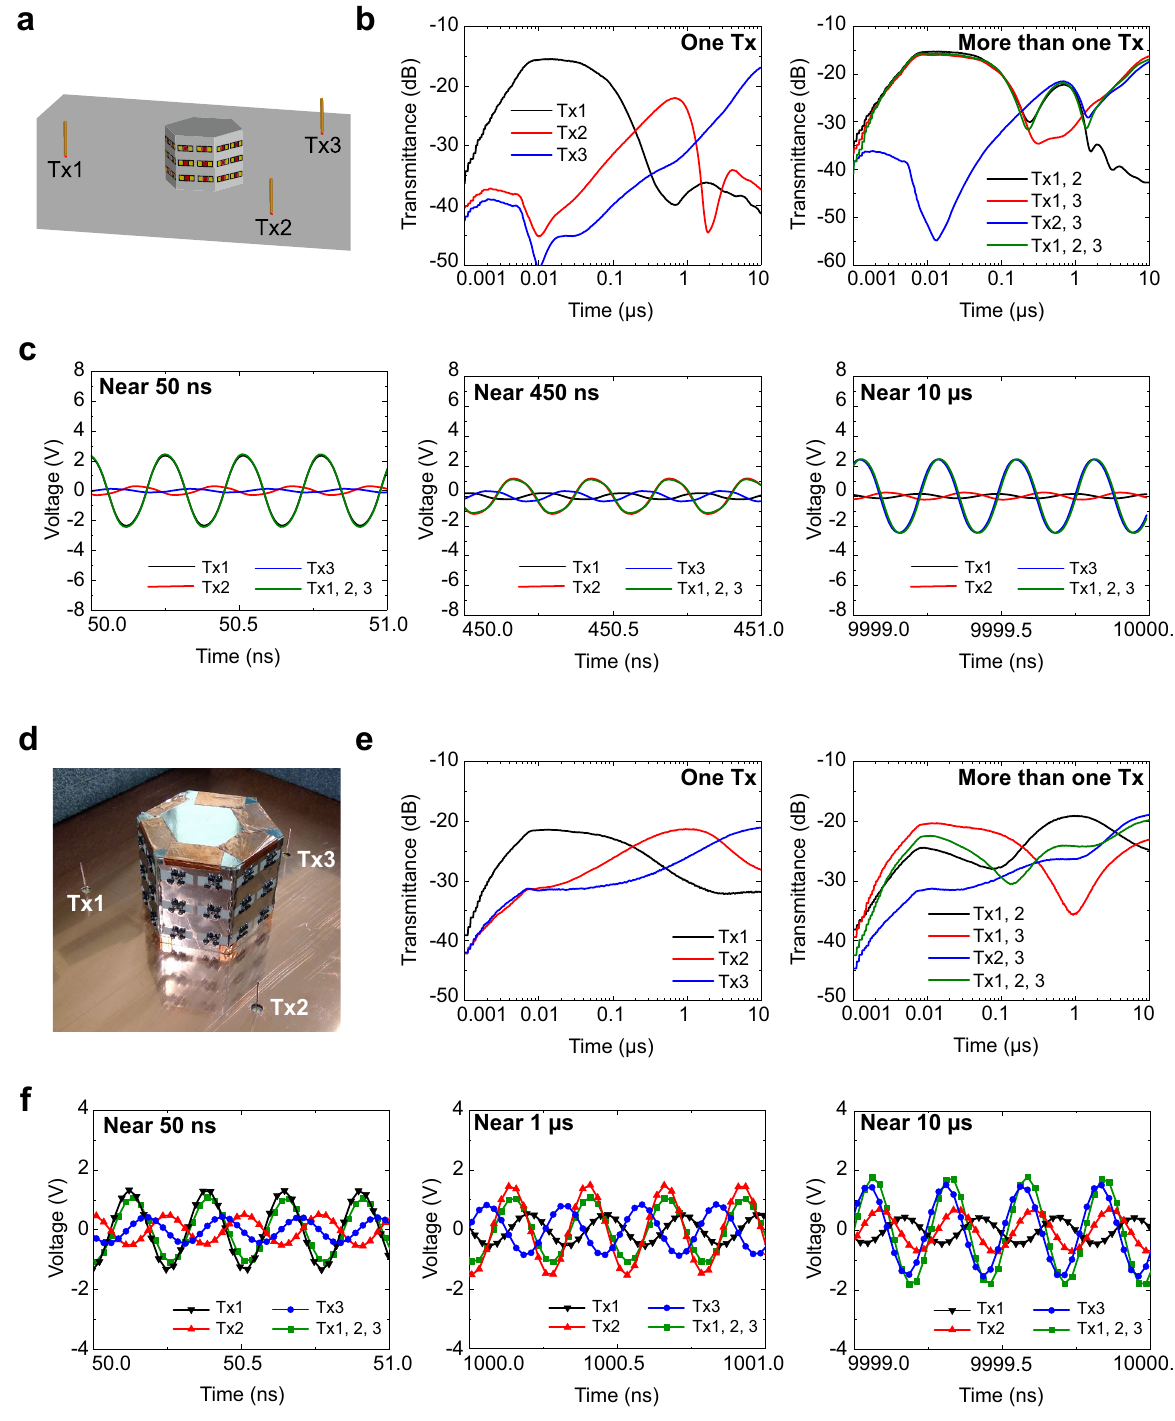
d Experimental sample and corresponding ( e ) transmittances and ( f ) received voltages with input power adjusted to 36dBm. The distance between the trans- mitters (Tx1 – Tx3) and the receiver (Rx) was 70mm. Additional simulation results are shown in SupplementaryFig.S23,wherethe distancebetweenthetransmitters and the receiver was increased to 200mm to represent a more realistic far- fi eld